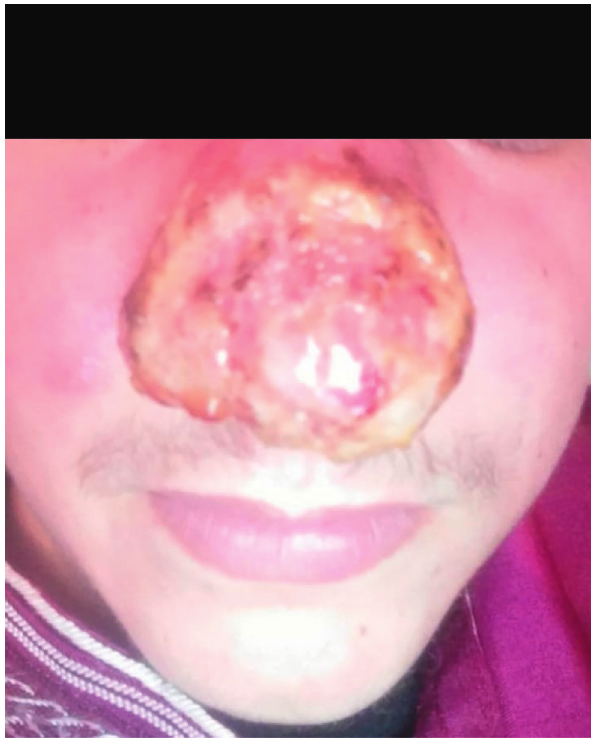
Figure 4: Inflammatory nasal swelling due to Leishmania tropica